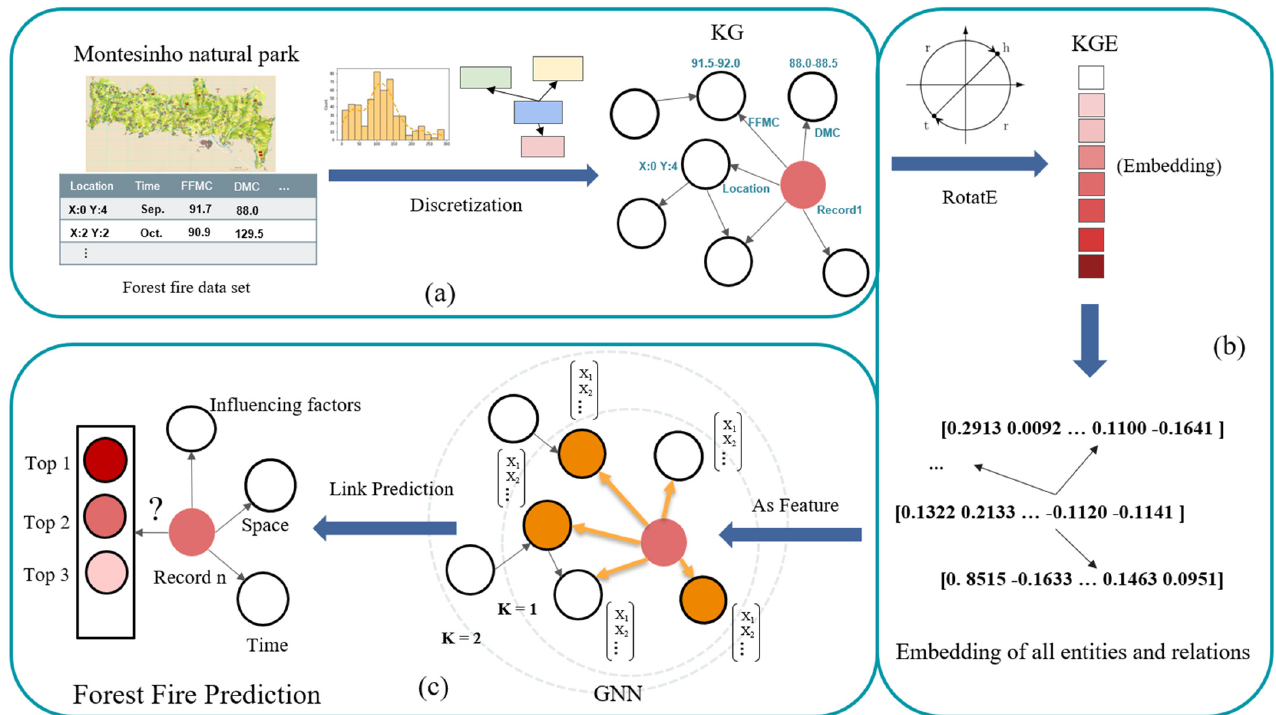
Figure 2. Details on forest fire prediction based on knowledge graphs and representation learning.